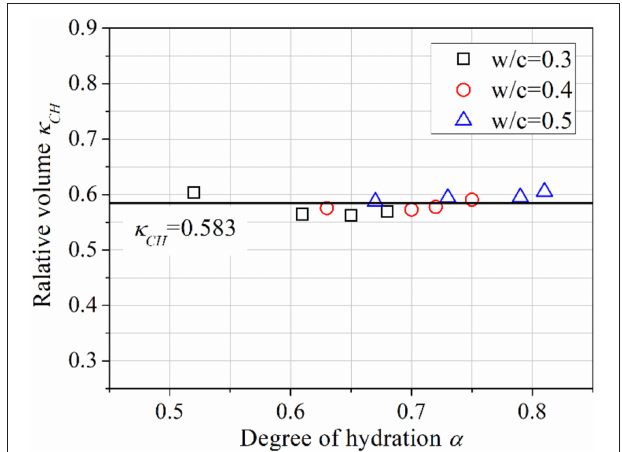
FIGURE 5 | Evolution of κ CH following degree of